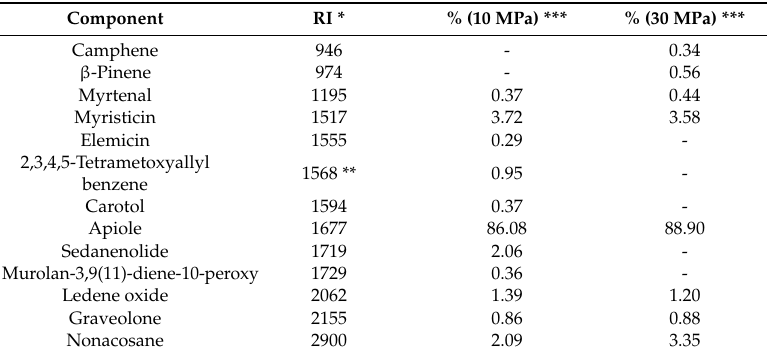
Table 3. Results of GC analysis of parsley